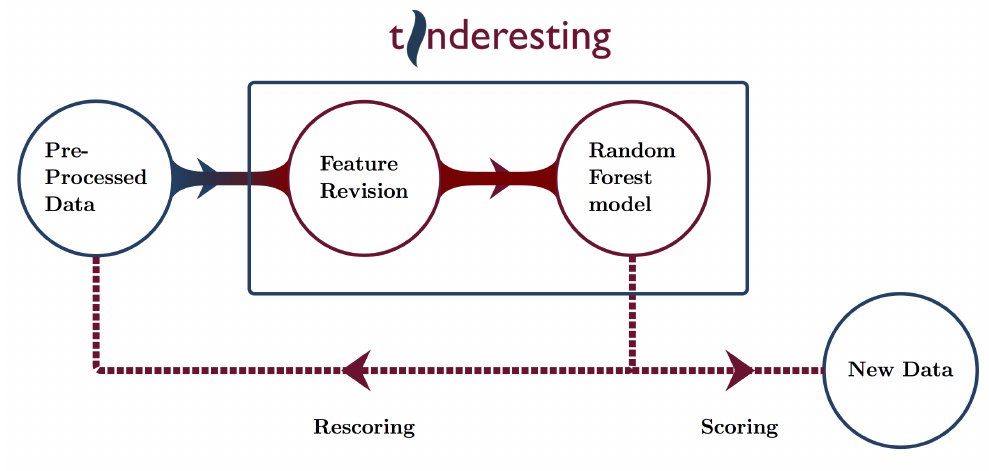
Figure 4. Overview of possible tinderesting